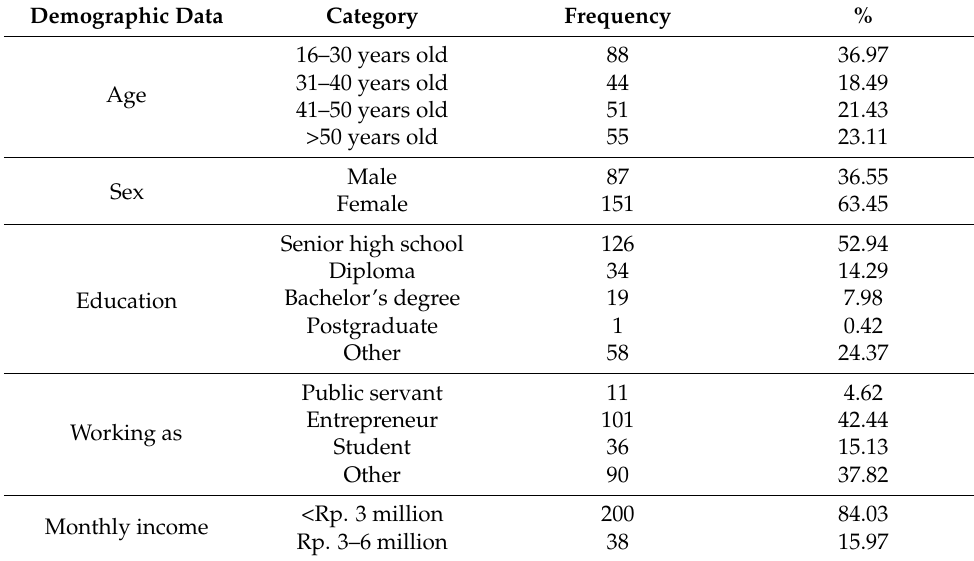
Table 2. Demographic data.